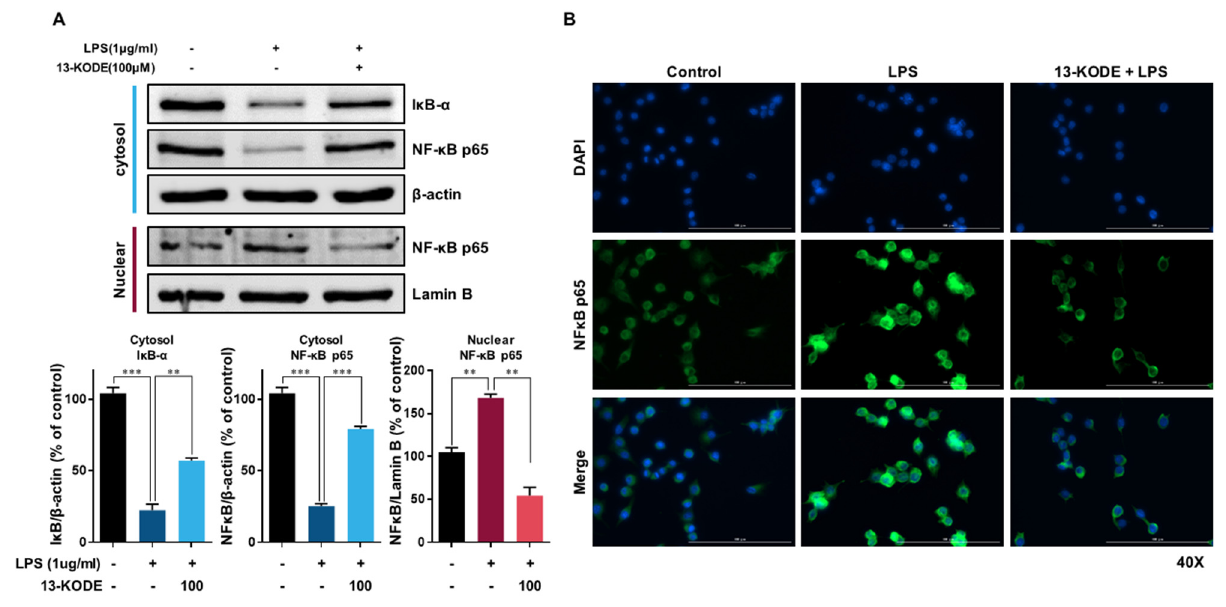
Figure 4. 13-KODE inhibits LPS-induced nuclear translocation of NF- κ B in RAW264.7 cells. Macrophage cells were treated with 100 µ M 13-KODE for 1 h followed by treatment with LPS (1 µ g/mL) for 30 min. ( A ) Nuclear and cytosolic fractions were subjected to SDS-PAGE followed by Western blotting using the indicated primary antibodies. The amounts of lamin B and β -actin were used as internal controls for the nuclear and cytosolic fractions, respectively. The values correspond to the means ± standard deviations, n = 3. ** p < 0.01 *** p < 0.001. ( B ) RAW264.7 cells were pretreated with 100 µ M 13-KODE for 1 h and then treated with LPS (1 µ g/mL) for 30 min. The localization of NF- κ B p65 and nuclei were determined by staining with anti-p65 (green) and DAPI (blue). Images were obtained by microscopy at 40X magnification and show representative macrophages (scale bar = 100 µm).